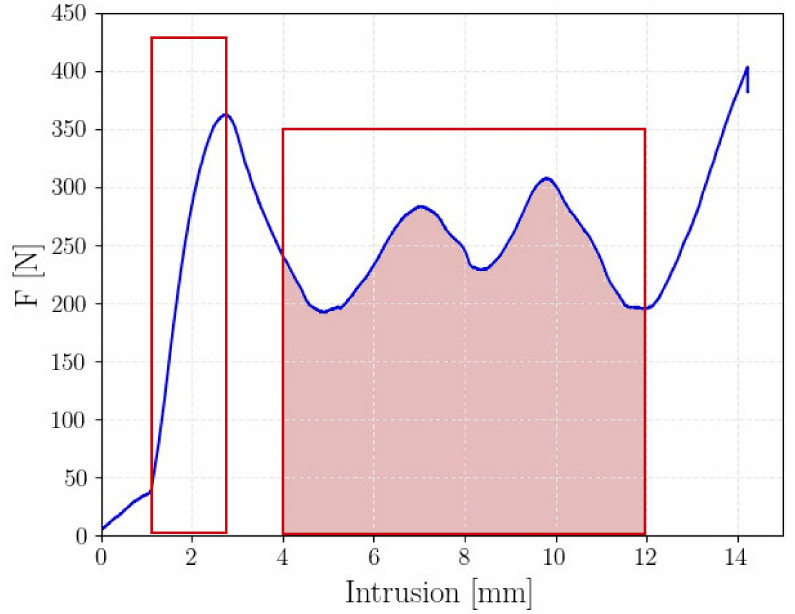
Figure 4. Example of a force–displacement curve acquired during the compression